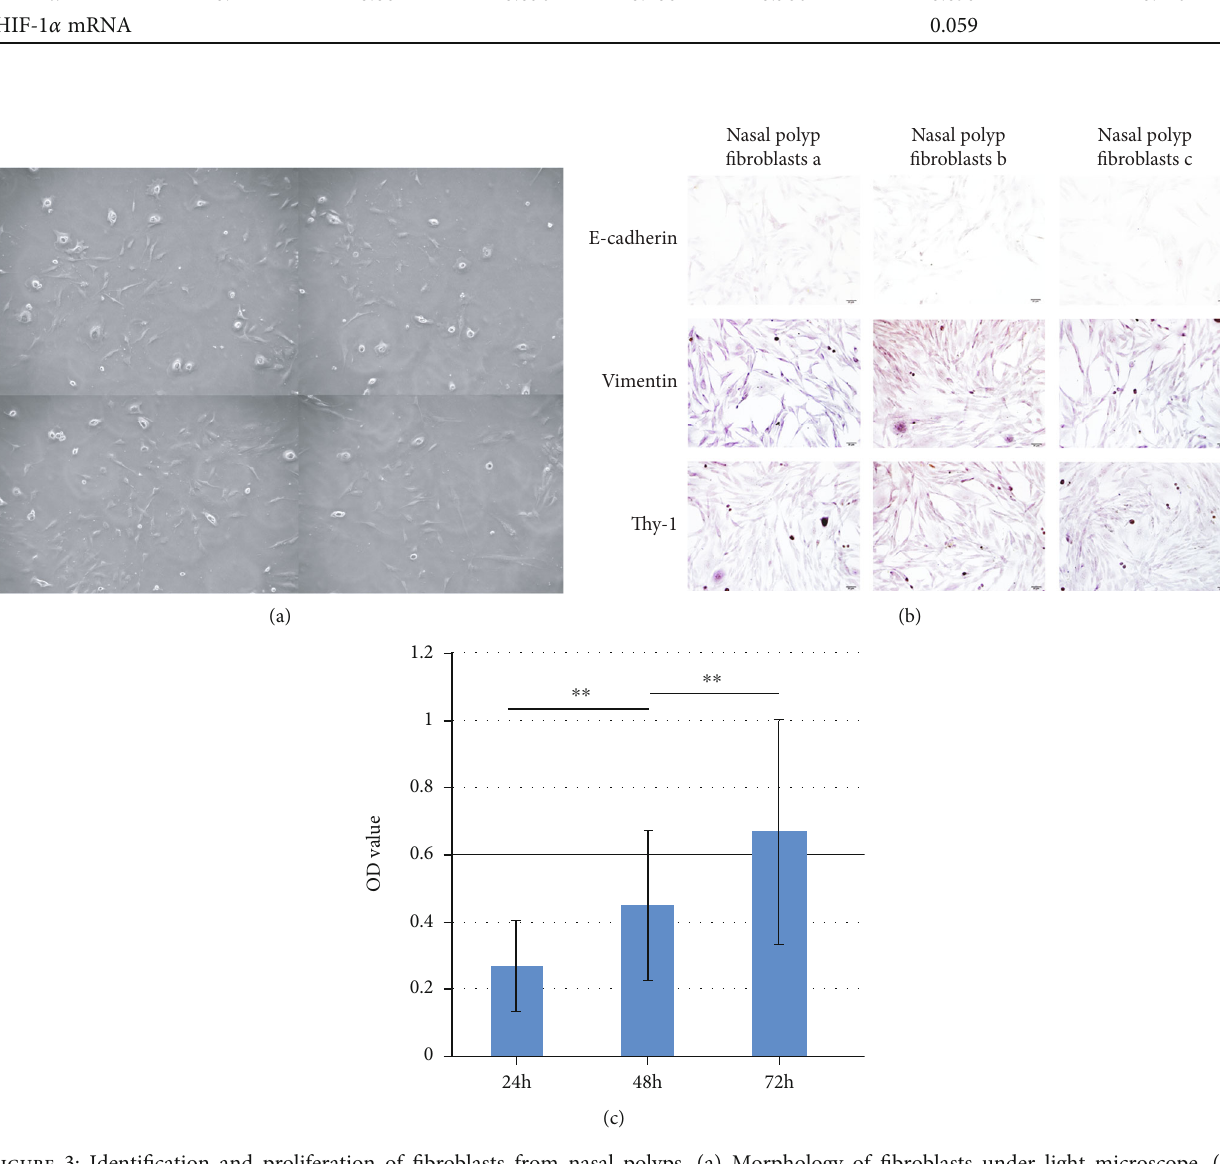
Figure 3: Identi fi cation and proliferation of fi broblasts from nasal polyps. (a) Morphology of fi broblasts under light microscope. (b) Expression of vimentin, Thy-1 protein, and E-cadherin protein in fi broblasts. (c) Cell activity increased and cell proliferation gradually increased with time. ∗∗ P < 0 : 001